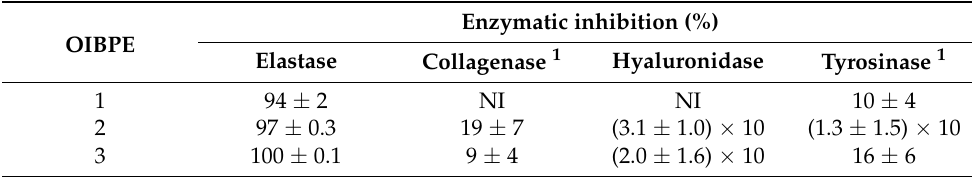
Table 4. Enzymatic inhibition assays of elastase, collagenase, hyaluronidase, and tyrosinase by olive by-products